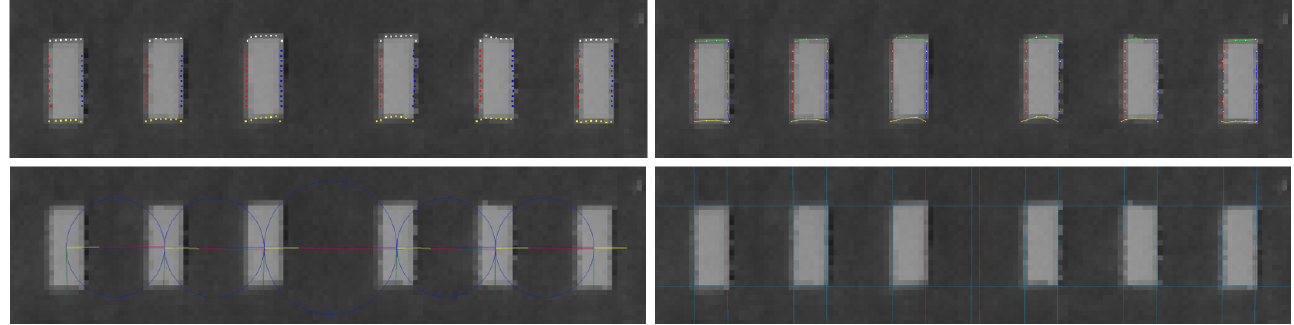
Figure 6. Bar detection is fine-tuned on the top-view projection of the detected